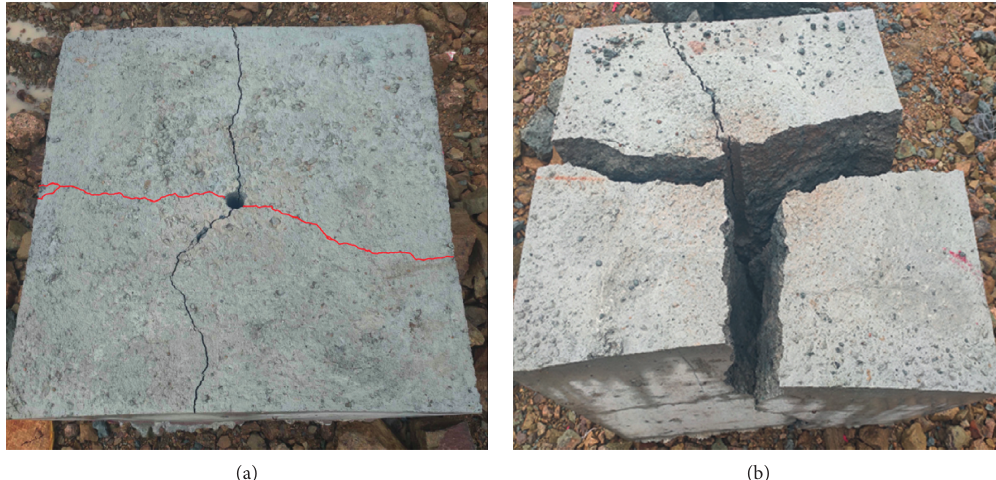
Figure 7: Damage and crack propagation of single-hole blasting: (a) conventional blasting; (b) multidirectional shaped charge blasting.